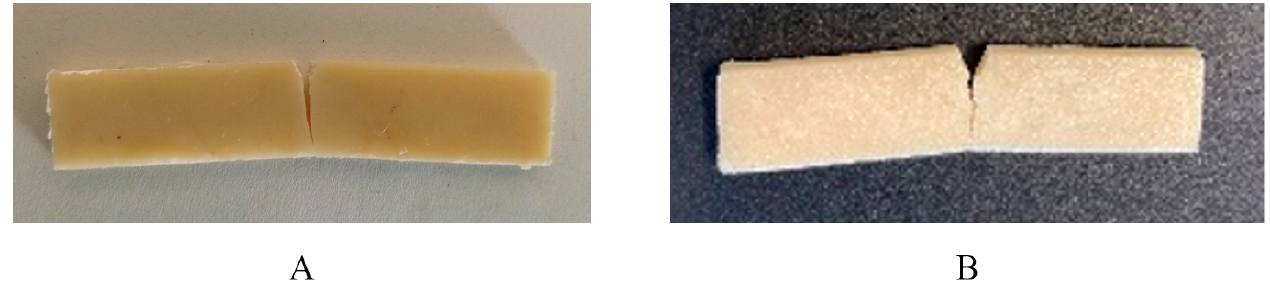
Figure 8. Partial fracture of the thermal compressed PHB/PCL (60/40)-5DCP-5PEG specimen (63.5 × 12.7 × 3.2 mm 3 , ASTM D256 standard) after impact test ( A ) and of the 3D printed PHB/PCL (60/40)-5DCP-5PEG samples (PCL 80 kDa) ( B ).